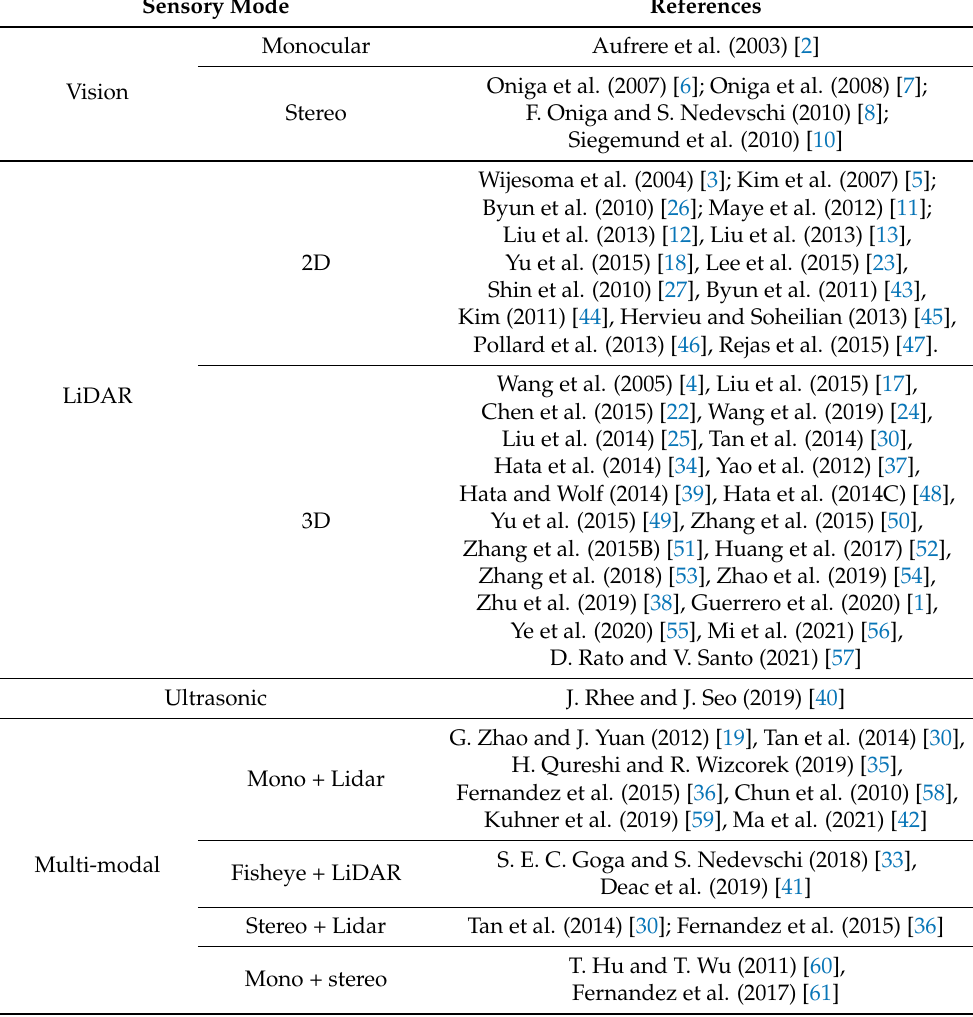
Table 1. Synthesis of contributions based on their perception